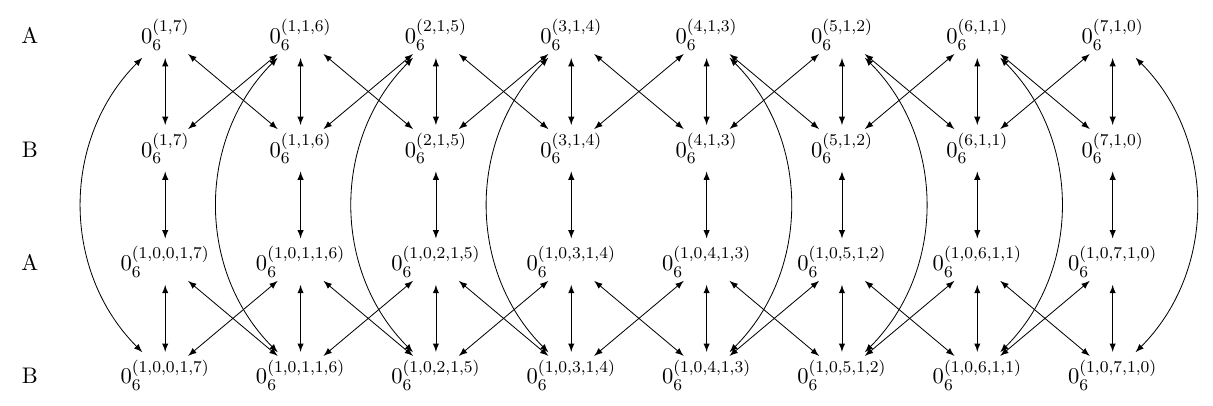
Figure 11 . The T-duality orbit of the 0 (1 ; 7)